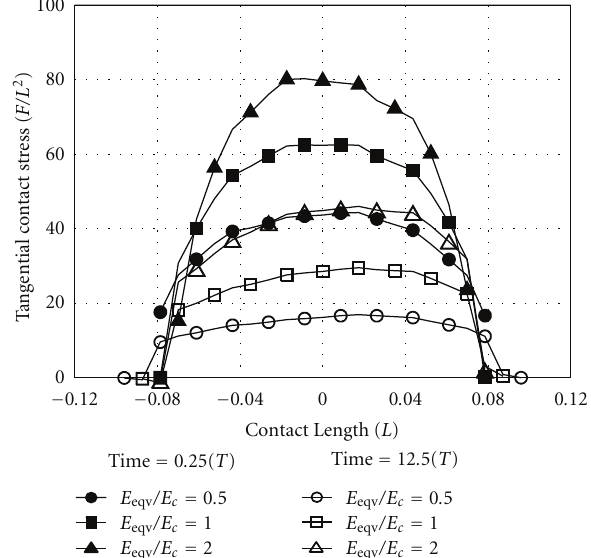
Figure 6: E ff ect of E eqv /E c on the tangential contact stress distribution.